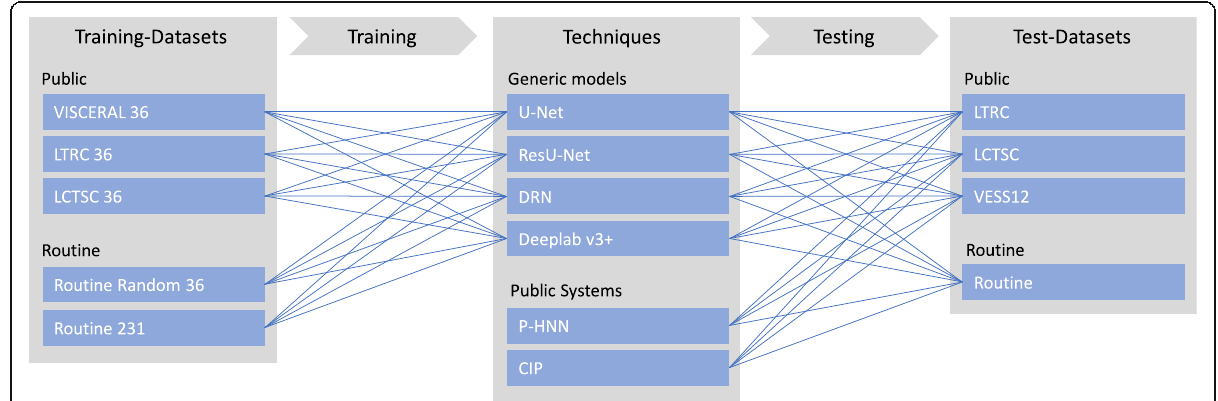
Fig. 1 Schematic overview of the training and testing performed. We collected public datasets and two datasets from the routine. We used these datasets to train four generic semantic segmentation models and tested the trained models on public and routine data together with readily available lung segmentation